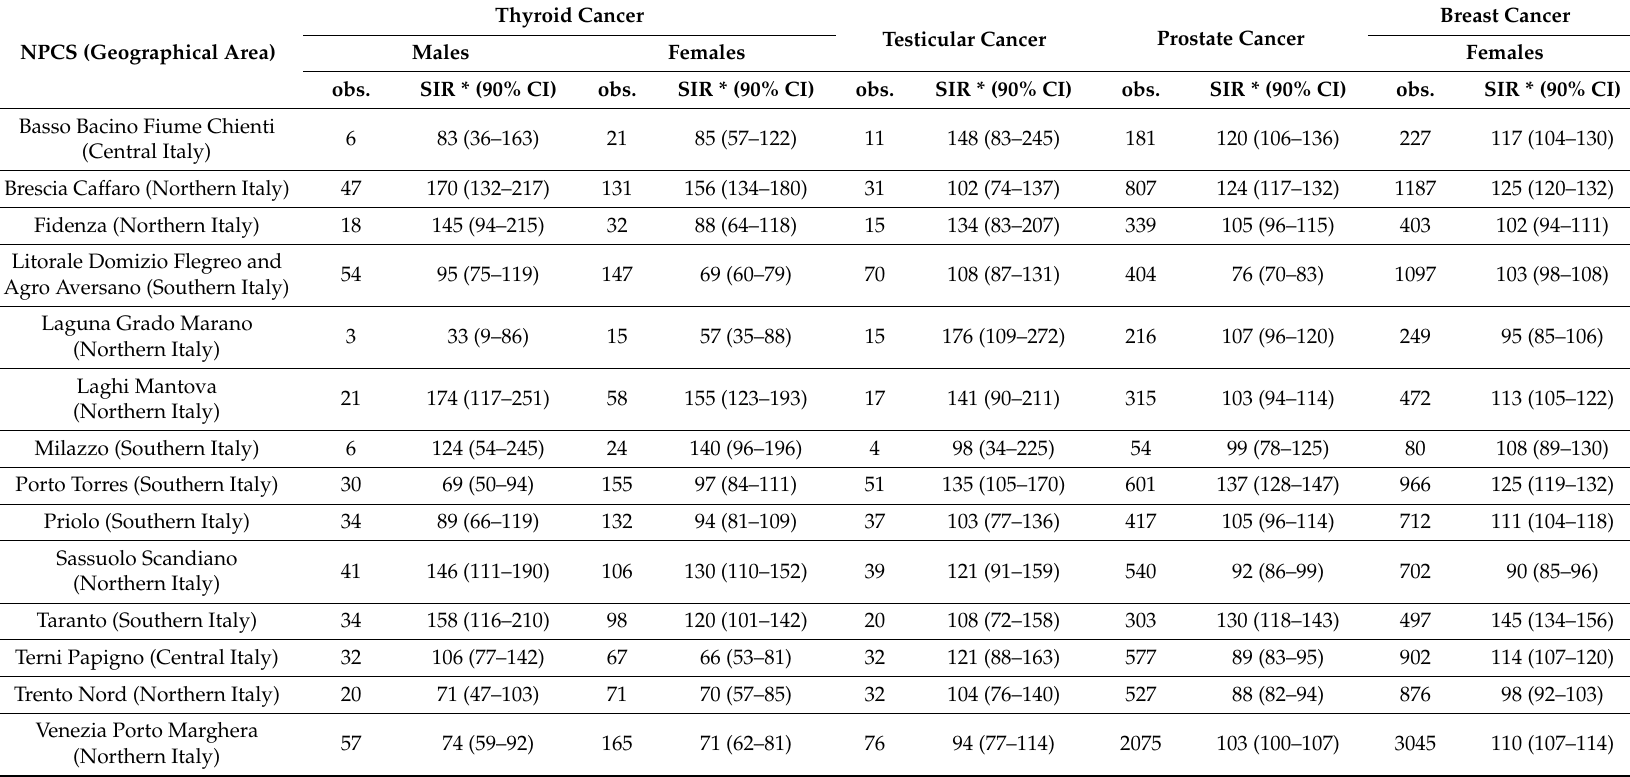
Table 3. Standardized Incidence Ratios (SIRs) with 90% confidence intervals (CIs), 1996–2005.